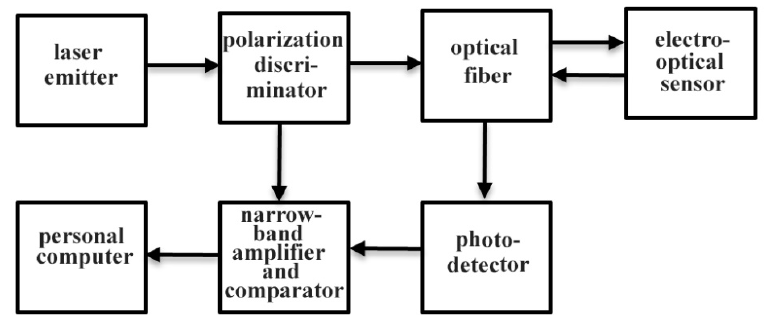
Figure 4. Flowchart of the device.